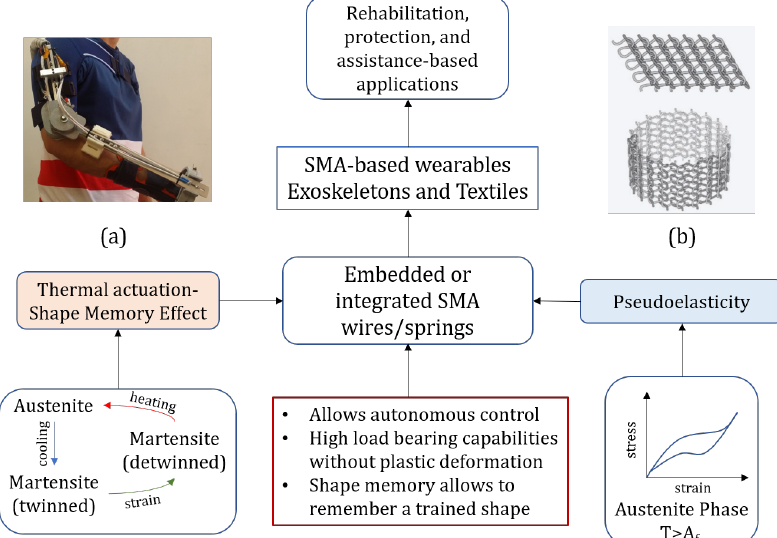
Figure 5. The SME and the Pseudoelasticity or Superelasticity are the properties that make SMA-based wearables an improved version of existing smart wearables. ( a ) Tendon driven elbow exoskeleton for joints rehabilitation [85], ( b ) SMA knit fabric for self fitting garment